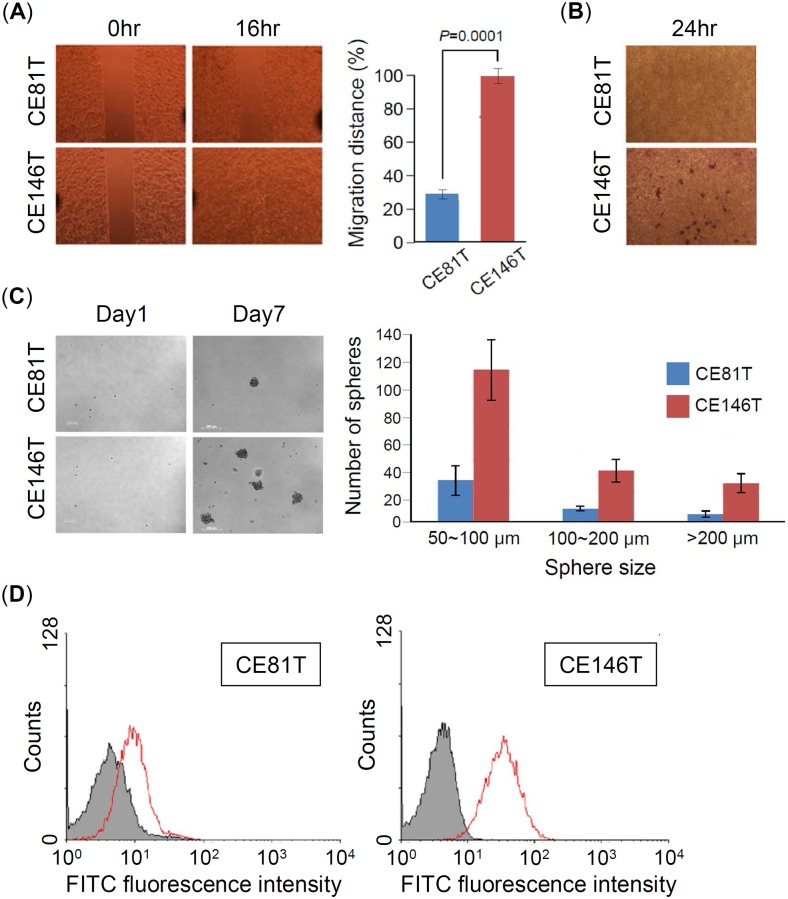
CE146T has more metastatic potential and stemness characteristics than CE81T.(A) Wound-healing assay. CE81T and CE146T were cultured in the ibidi Culture-Insert well, and the migration images of cancer cells were recorded at 0hr (removal of Culture-Insert) and 16hr. Migration distance was measured using software image J. (B) Matrigel invasion assay. Representative photographs contain invaded cancel cells that were stained with crystal violet. (C) Sphere formation assay. Various sizes of spheres in CE81T and CE146T were counted at day 7. Experiments were performed in triplicate (mean ± SD). (D) CD44 expression in CE81T and CE146T was measured using flow cytometry.